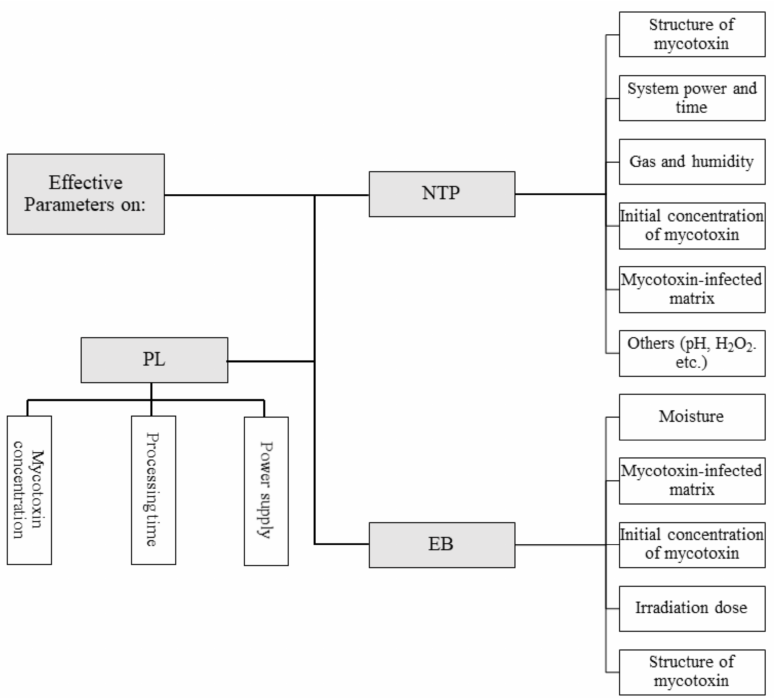
Figure 1. The outline of most important parameters of presented non-thermal methods (EB—electron beam, NTP—non-thermal plasma, PL—pulsed light) with the respect to the efficiency against myco- toxin removal investigated among studies. The mycotoxin concentration, processing time, or dose are the common parameters for all methods. Moreover, each method has its own specific